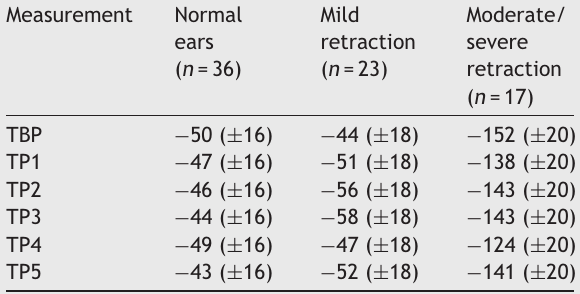
ment]) = 0.716; ( p [group]) < 0.001.